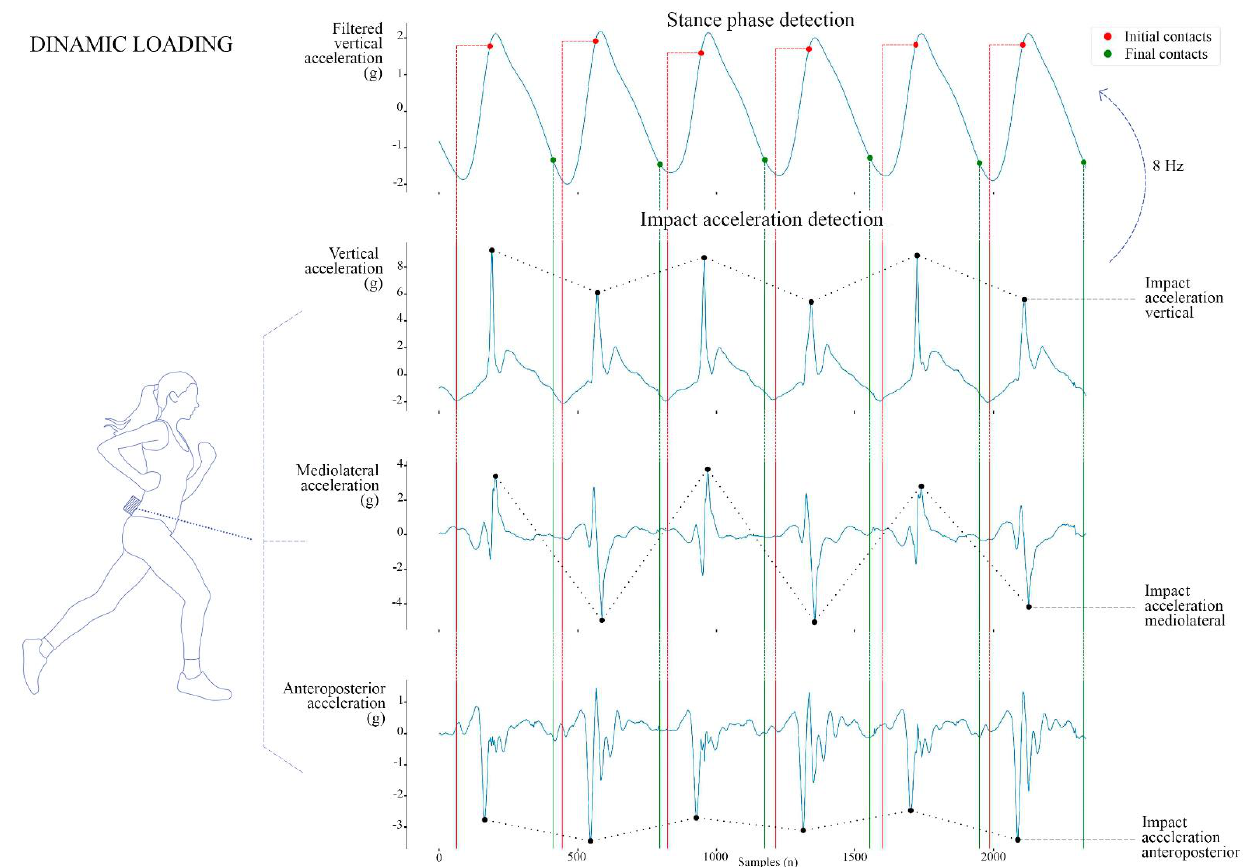
Figure 2. Extraction of the impact acceleration. Dotted lines represent the windows during which impact peaks were detected. Vertical impact acceleration was positive, as it reflected the contributions of the impact peak in the vertical ground reaction forces. Mediolateral impact acceleration was extracted using the absolute value, as it was positive and negative for right and left steps respectively. Anteroposterior impact acceleration was negative as it corresponded to the braking phase of running. Initial and final contacts were obtained using the step detection method proposed by Benson et al. [12], which preprocessed the vertical signal with a low-pass filter.